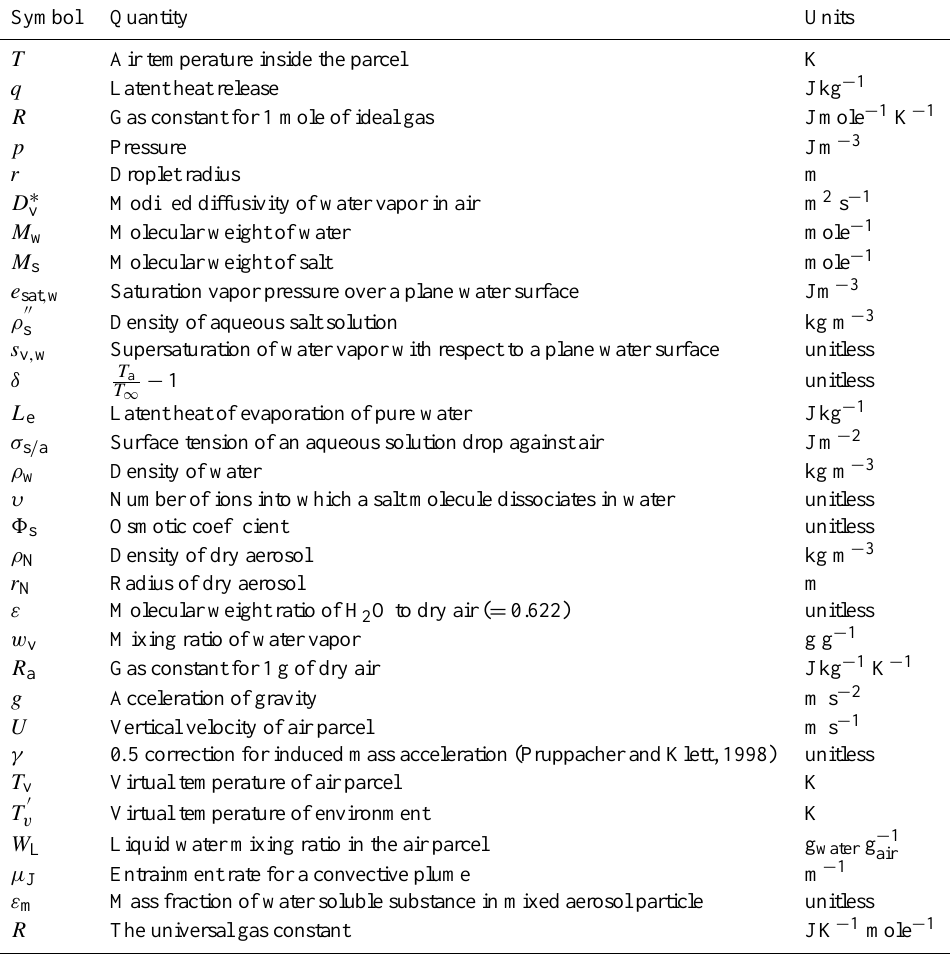
Table A1. List of symbols. Symbol Quantity Units T Air temperature inside the